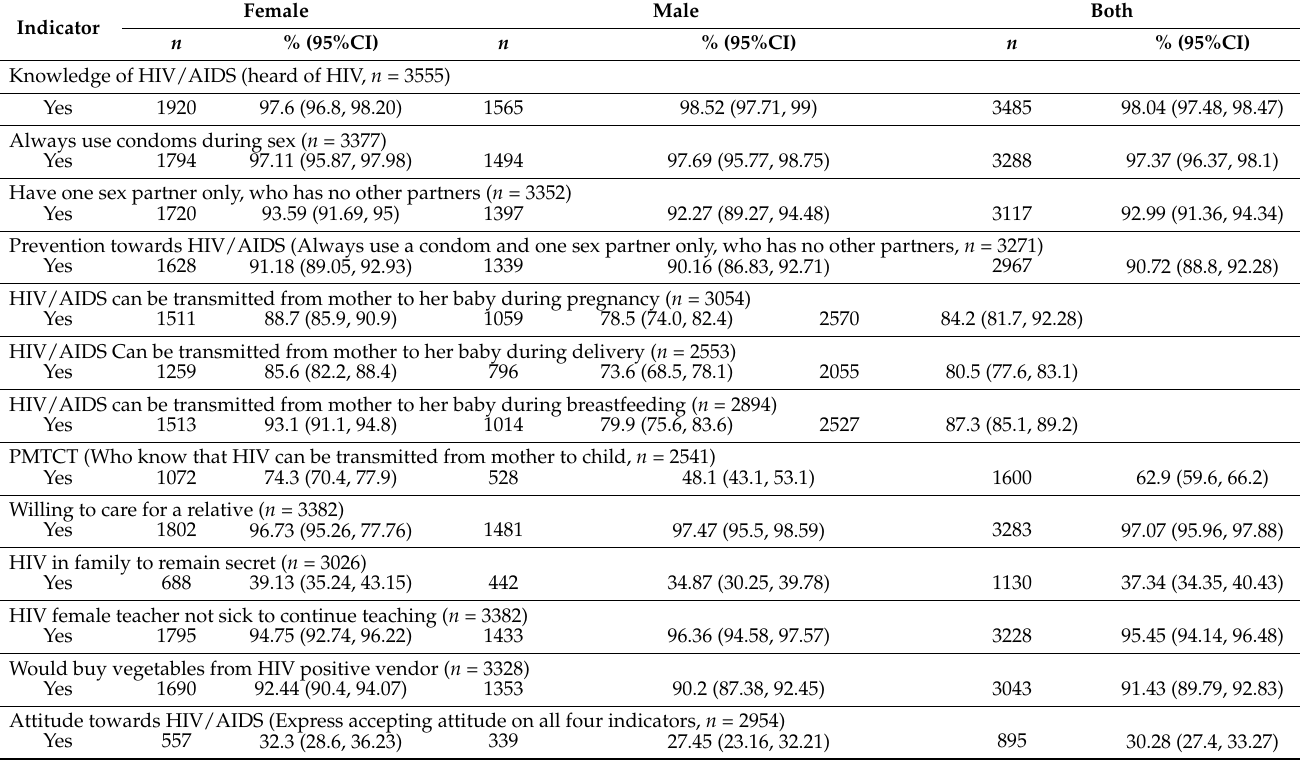
Table 2. Responding ‘yes’ to the question about knowledge, attitude, and prevention towards